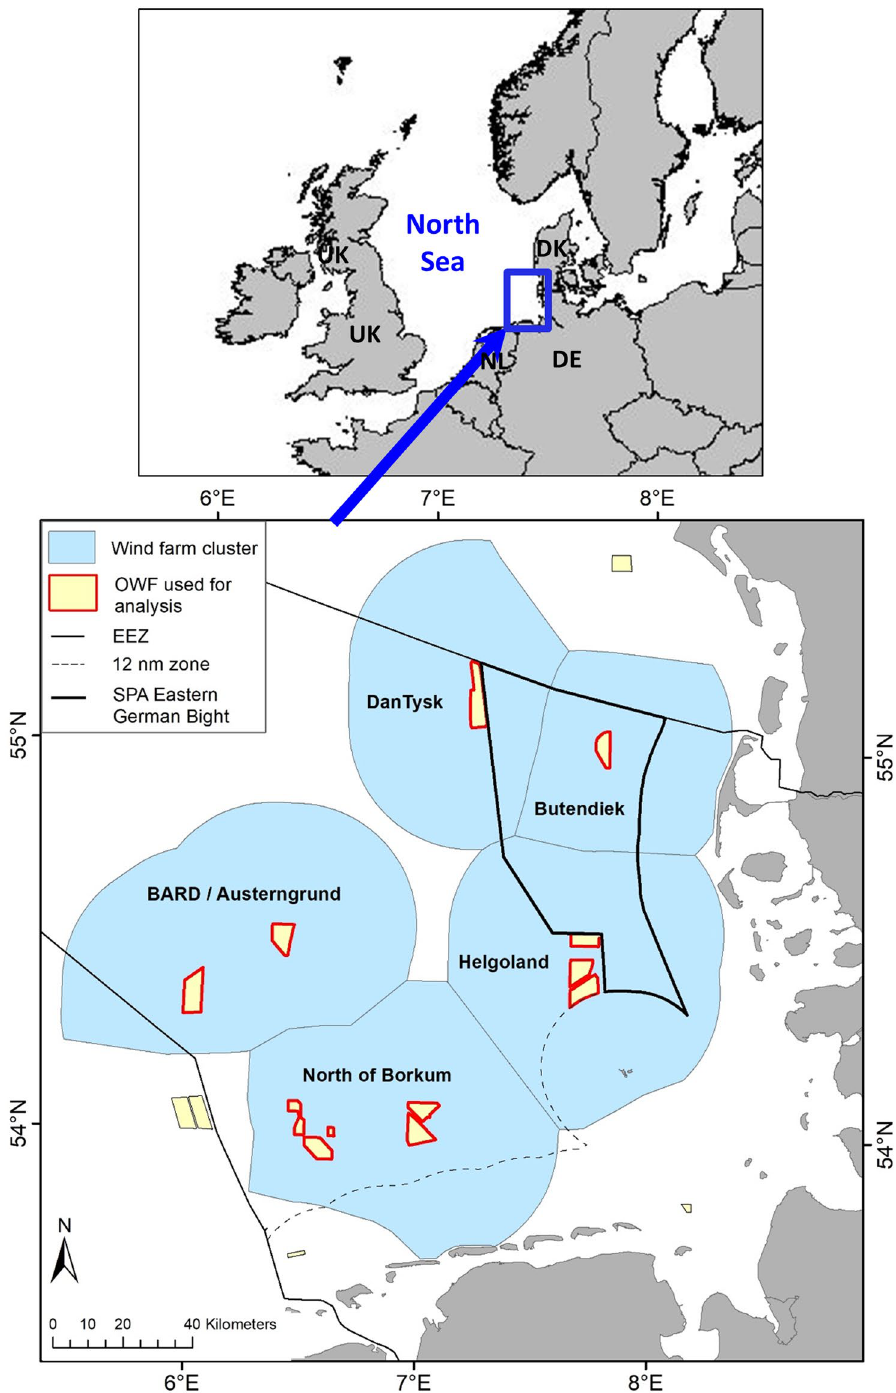
Figure 1. Location of the five wind farm clusters in the southeastern North Sea in northwest Europe. Blue areas delineate the five considered wind farm clusters. The map represents all OWFs in 2015 and 2016. The thick black line indicates the Special Protection Area ‘Eastern German Bight’ designated according to the EU Birds Directive. The thin black line shows the borders of the EEZs (Exclusive Economic Zones) of Denmark (in the north), Germany (in the middle) and the Netherlands (in the south). The map was generated in ArcGIS 10.3 for Desktop, https:// www. esri.